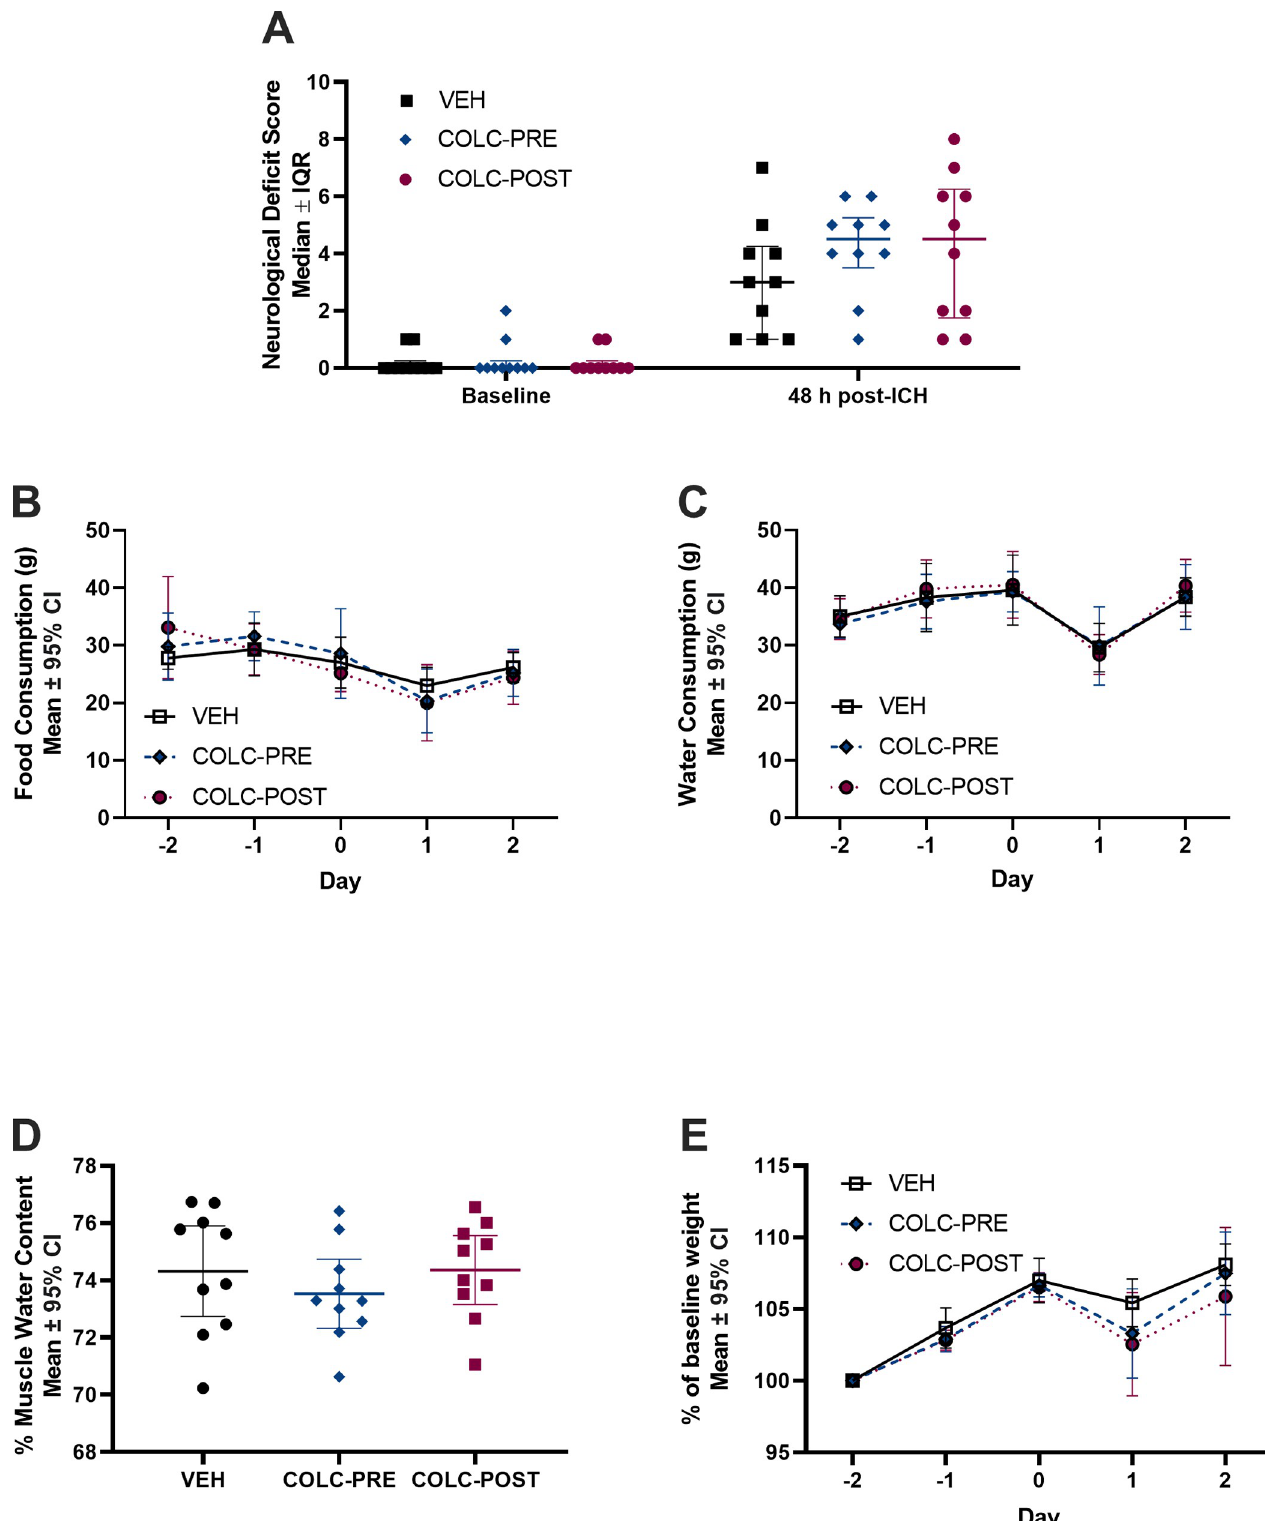
Fig 2. Experiment 2. ICH significantly worsened NDS at 48 hours post-ICH (A, p < 0.001), but no differences were found among the three groups (p = 0.350). Food consumption (B, p = 0.897), water consumption (C, p = 0.965), and muscle water content (D, p = 0.543) did not differ between groups at any time assessed. ICH resulted in significant weight loss post-ICH (E, p < 0.001), but no difference among groups were found at any time (p > 0.999). n = 10/group. https://doi.org/10.1371/journal.pone.0276405.g002 PLOS ONE | https://doi.org/10.1371/journal.pone.0276405 October 18,